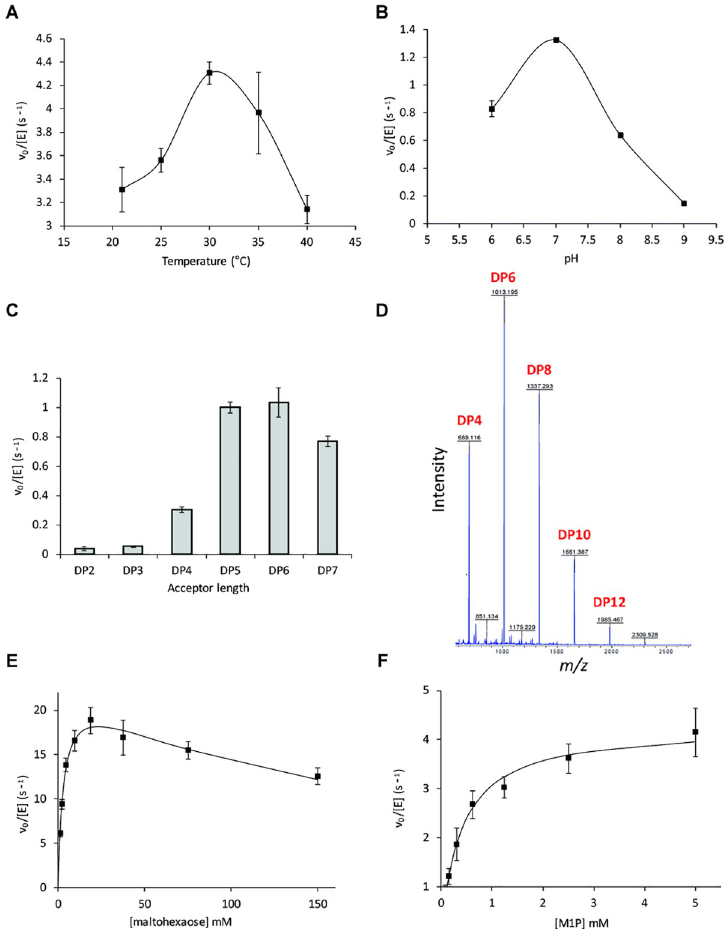
Fig 4. A-C) Dependence of PAO1 GlgE activity on pH, temperature, and acceptor chain length. GlgE activity with M1P and an acceptor was monitored by detecting the release of inorganic phosphate in a stopped assay. A) The temperature optimum of GlgE activity with maltohexaose was 30˚C. B) The pH optimum of GlgE activity with maltohexaose was 7. C) GlgE preferentially extends linear maltooligosaccharides with a DP of 5 to 7. All data points represent means of triplicate measurements and standard errors. D) PAO1 GlgE exhibits disproportionation activity. GlgE was incubated with maltohexaose and the resulting product mixture was analysed using MALDI mass spectrometry. The DP of the maltooligosaccharide products formed is indicated. Note that GlgE transfers maltose groups between maltooligosaccharides. E-F) The kinetics of the PAO1 GlgE-catalysed maltohexaose extension by M1P. E) GlgE activity was determined as a function of maltohexaose concentration using 1 mM M1P. Substrate inhibition was evident at high maltohexaose concentrations. The smooth line represents the fit to the data using the Michaelis-Menten equation modified to allow for substrate inhibition. F) GlgE activity was determined as a function of M1P concentration using 1 mM maltohexaose. No substrate inhibition was observed with M1P. The smooth line represents the fit to the data using the Michaelis-Menten equation. All data points represent means of triplicate measurements and standard errors. respectively (Fig 4A and 4B ). The enzyme preferentially extended linear maltooligosaccharides with a degree of polymerisation (DP) of 5–7 (Fig 4C ). The enzyme exhibited disproportion- ation activity with maltohexaose, yielding both longer and shorter oligosaccharides by two glu- cose residues (Fig 4D ) as reported for GlgE enzymes from other bacteria [26, 57]. This side reaction is likely responsible for the substrate inhibition observed with maltohexaose in the polymerase reaction with M1P. Thus, the kinetic constants associated with maltohexaose extension by 1 mM M1P were k catapp 23 ± 1 s -1 , K mapp 3.2 ± 0.4 mM and K iapp 171 ± 26 mM